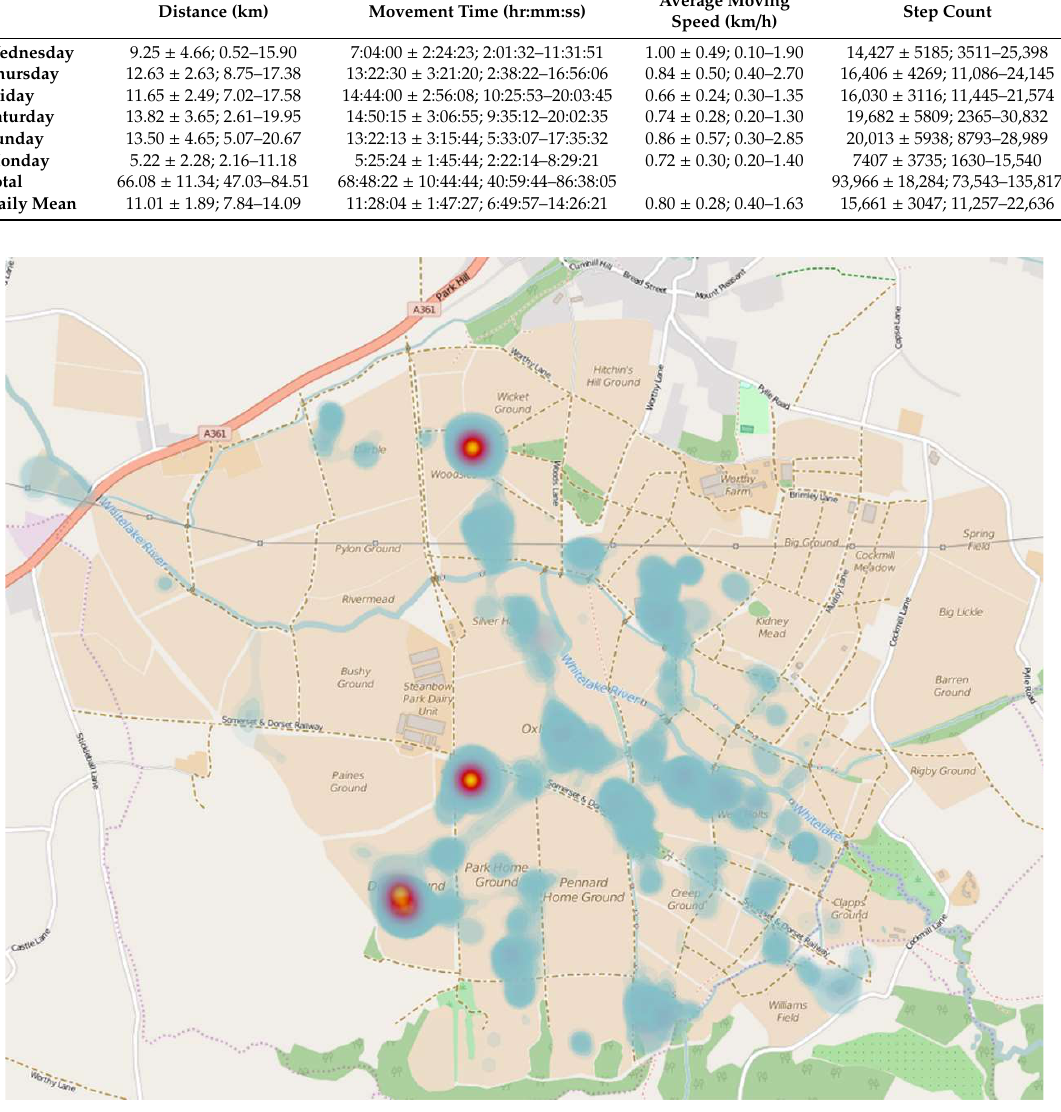
Figure 2. Heatmap indicating areas of highest participant duration during the festival (High—Yellow; Medium—Blue).